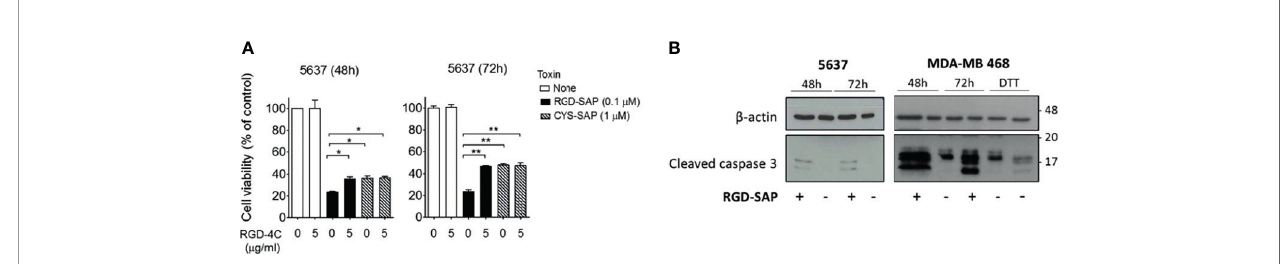
FIGURE 3 | RGD-SAP target speci fi city and caspase 3 activation. (A) 5637 bladder cancer cells were incubated with RGD-SAP (0.1 µM) or CYS-SAP (1 µM) in the presence or absence of ACDCRGDCFC peptide (5 µM). The cell viability was evaluated after 48 and 72 h by MTT assay. Results are shown as mean ± SE. *p < 0.05, **p < 0.01 by non-parametric unpaired t test. (B) The activation of apoptosis via caspase 3 cleavage upon RGD-SAP (30 nM) treatment was evaluated in 5637 and MDA-MB-468 cells by analyzing the intracellular levels of caspase-3. Cells were incubated with RGD-SAP for 48 and 72 h and cell lysates were analyzed by western blot with anti-caspase-3 or an anti- b -actin antibodies for protein normalization. DTT (2 mM) was included as positive control for caspase-3 activation.